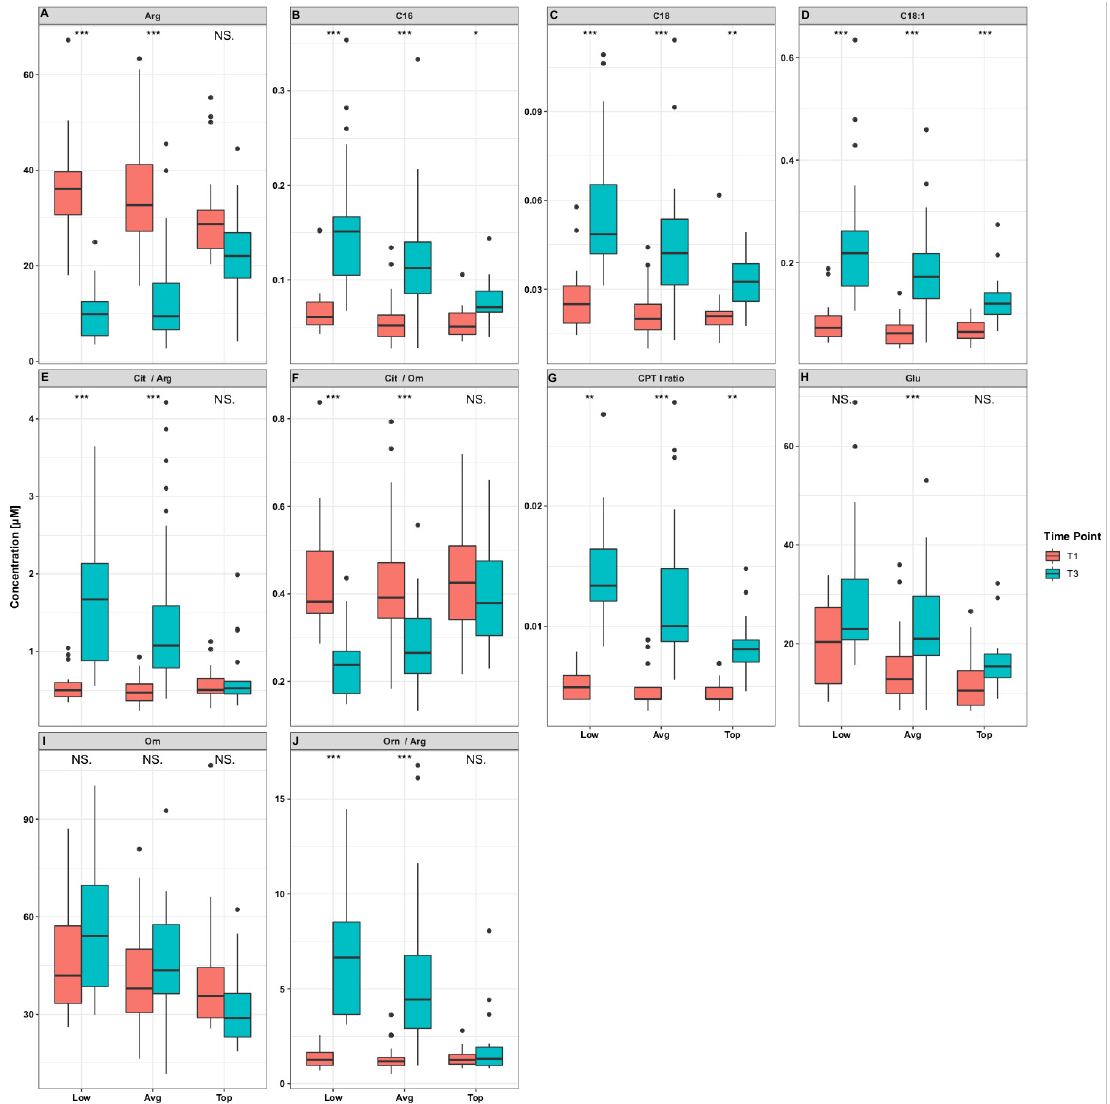
Figure 4. Significant metabolites ( q < 0.05) after comparison of top, average, and low performers at time points T1 and T3. T1 = 72 h before the race (training phase), T3 = immediately after the race. In most instances, the differences between T1 and T3 were less pronounced in top performers in comparison to average and low performers. The asterisks refer to pairwise comparisons with a Wilcoxon test procedure after Benjamini–Hochberg correction. Asterisks denote a significant difference between time point 1 and time point 3 for each individual performer class. * q < 0.05, ** q < 0.01, *** q < 0.001, NS. Non-significant.